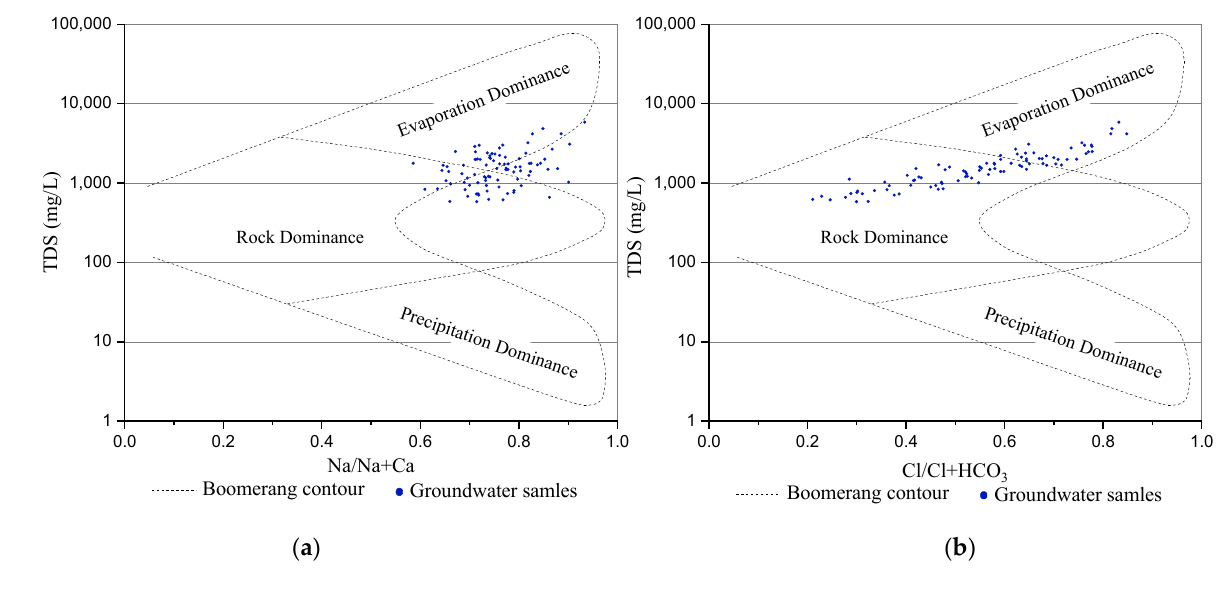
Figure 8. Gibbs diagram showing the mechanisms controlling groundwater chemistry in the study area. ( a ) major cations vs. TDS; ( b ) major anions vs. TDS. High TDS levels were found in groundwater of the Yaobao Oasis. The Na/(Na+Ca) and Cl/(Cl+HCO 3 ) ratios varied within 0.6–1 and 0.2–0.8, respectively. Most groundwater samples were distributed in the middle to the upper parts of the Gibbs diagrams. Accord-